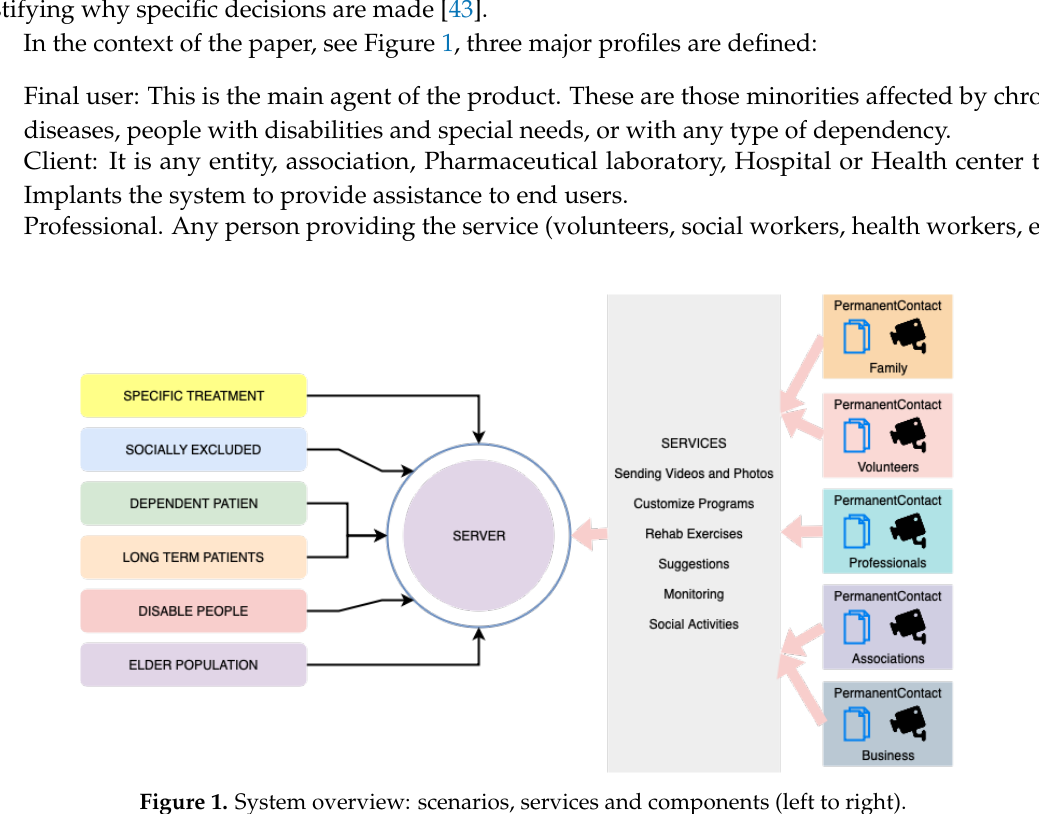
Figure 1. System overview: scenarios, services and components (left to